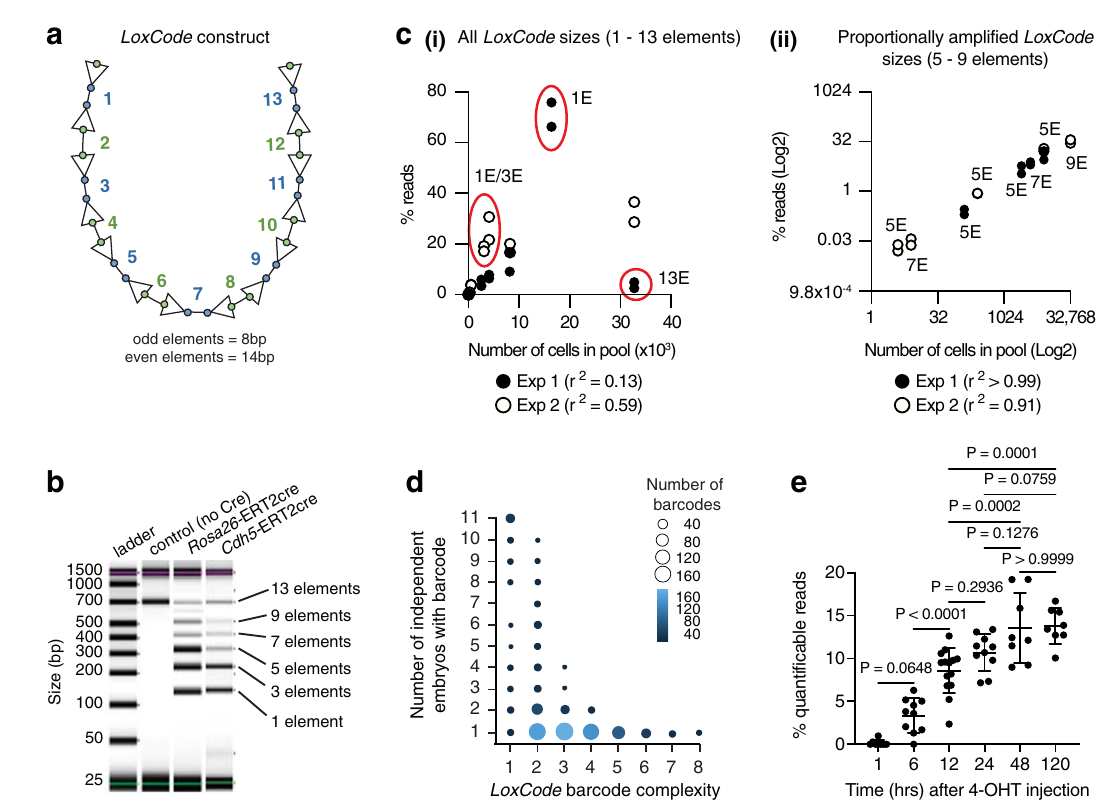
Fig. 2 | In vivo cellular barcoding using the LoxCode mouse line. a Schematic of the LoxCode construct: LoxP sites (arrowheads), 1 – 13: unique DNA sequences (elements). LoxCode constructsize=616nucleotides. b Representativeexamplesof LoxCode construct PCR products before and after recombination with Rosa26 or Cdh5 driven ERT2cre recombinase. Number of elements per fragment isindicated. Data is representative of n =104 independent libraries prepared from crosses with Cdh5 ERT2Cre mice and n =180 independent libraries prepared from crosses with Rosa26 ERT2Cre mice. c Proportionality of barcode ampli fi cation in control pools. (i) 1 element and 13 element barcodes are over- and under- represented respec- tively.(ii)5 – 9elementbarcodesequencesarewithinanear-linearmanner,allowing for reliable quanti fi cation of relative clonal output to all assessed lineages (bio- mass). Note, multiple representation of 1 and 5 element (E) barcodes re fl ects the